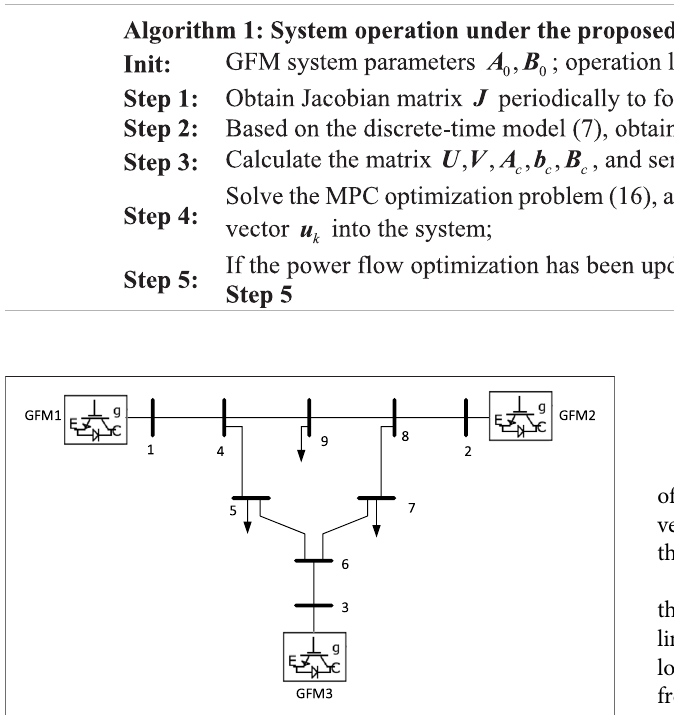
TABLE 1 | Implementation of the proposed MPC frequency regulation algorithm.